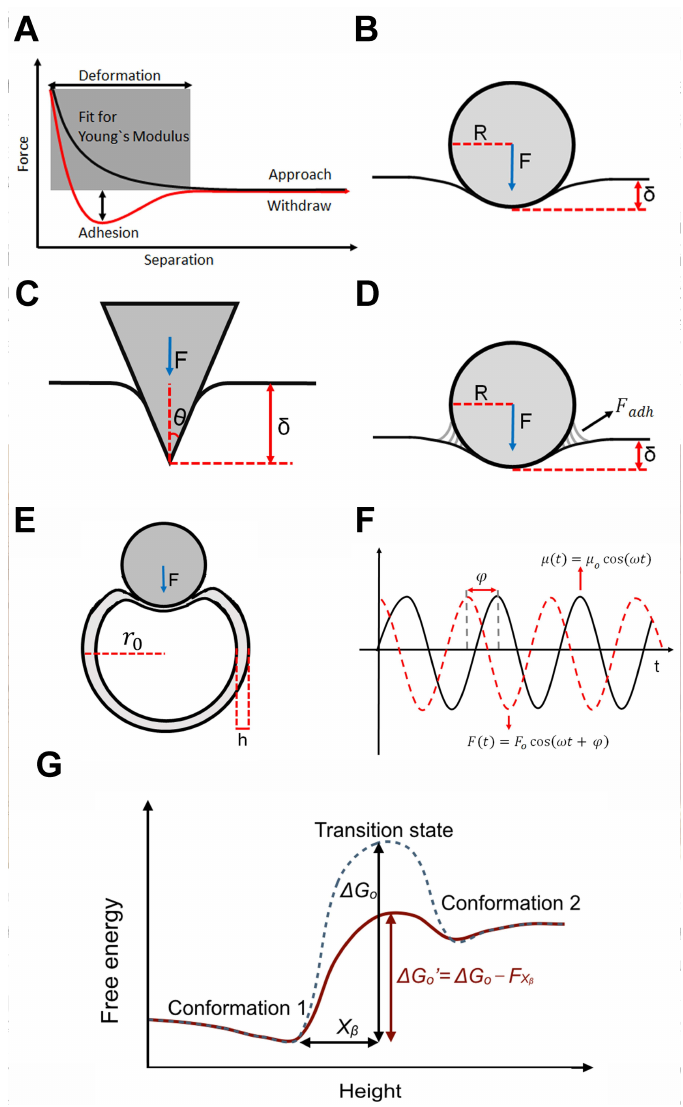
Figure 1. Overview of the theories generally used to interpret compressive force spectroscopic (CFS) data. ( A ) Schematic diagram of the experimental force versus distance curves showing the region of the data used for many mechanical measurements of biosamples; ( B – D ) Various models used to obtain a measure of the Young’s modulus of cells, including the Hertz model ( B ); Sneddon model ( C ); and the Derjaguin–Muller–Toporov (DMT) model ( D ). In each, the tip is colored grey and the indentation depth is δ ; ( E ) Schematic diagram showing the analysis of the virus capsid as a thin spherical shell; ( F ) Depiction of the dynamic oscillatory model used to determine the visco-elasticity of cells; ( G ) Energy landscape model for the interpretation of single molecule CFS